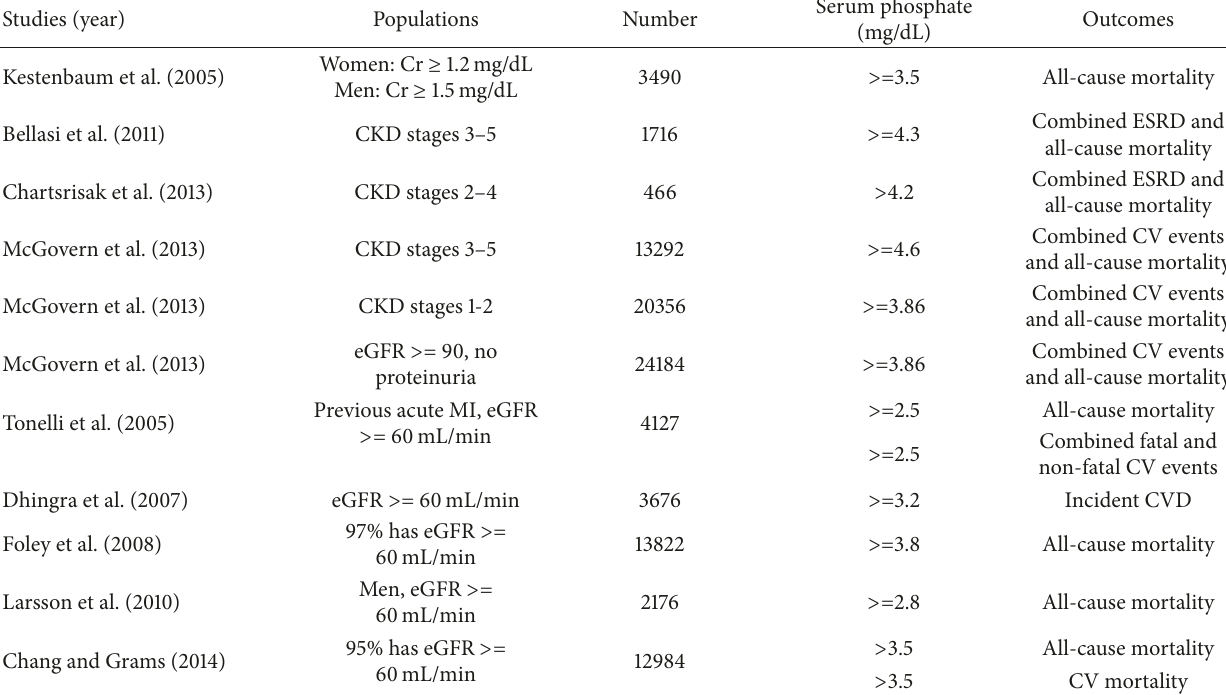
Table 1: Thresholds of serum phosphate for cardiovascular events and mortality in early-stage CKD and general populations.